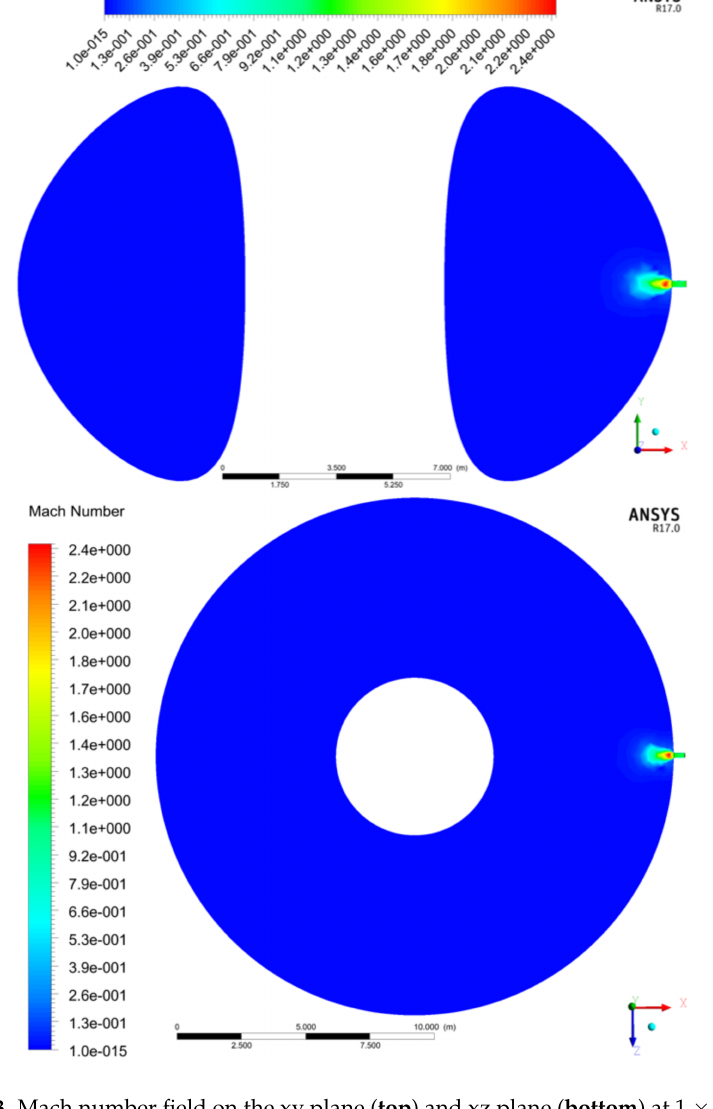
Figure 3. Mach number field on the xy plane ( top ) and xz plane ( bottom ) at 1 × 10 − 2